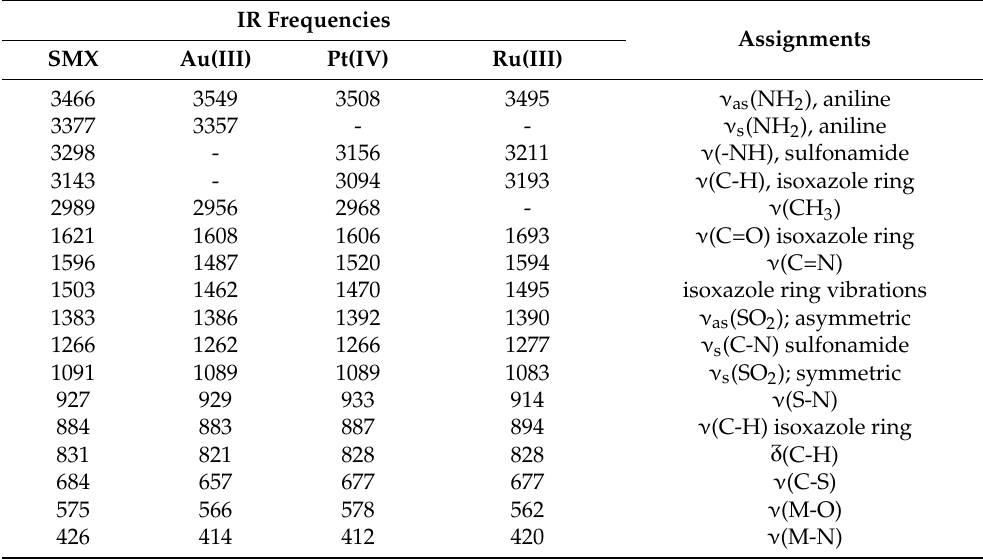
Table 3. IR frequencies (cm − 1 ) and provisional positions for sulfamethoxazole, Au-sulfamethoxazole, Pt-sulfamethoxazole, and Ru-sulfamethoxazole complexes.